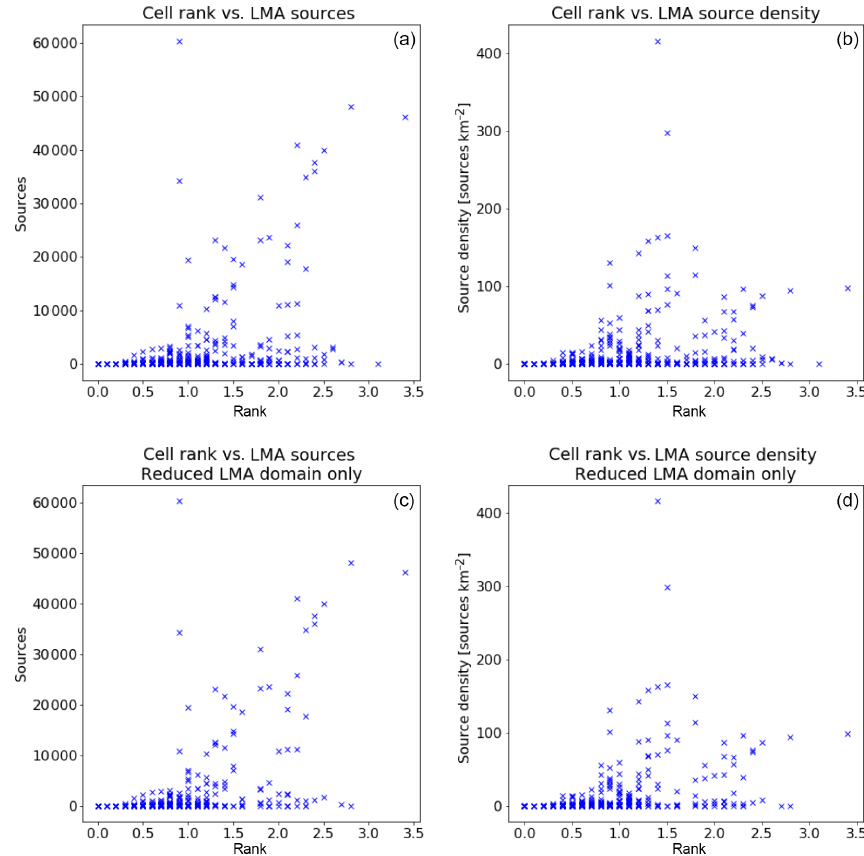
Figure 5. As in Fig. 4, but for LMA